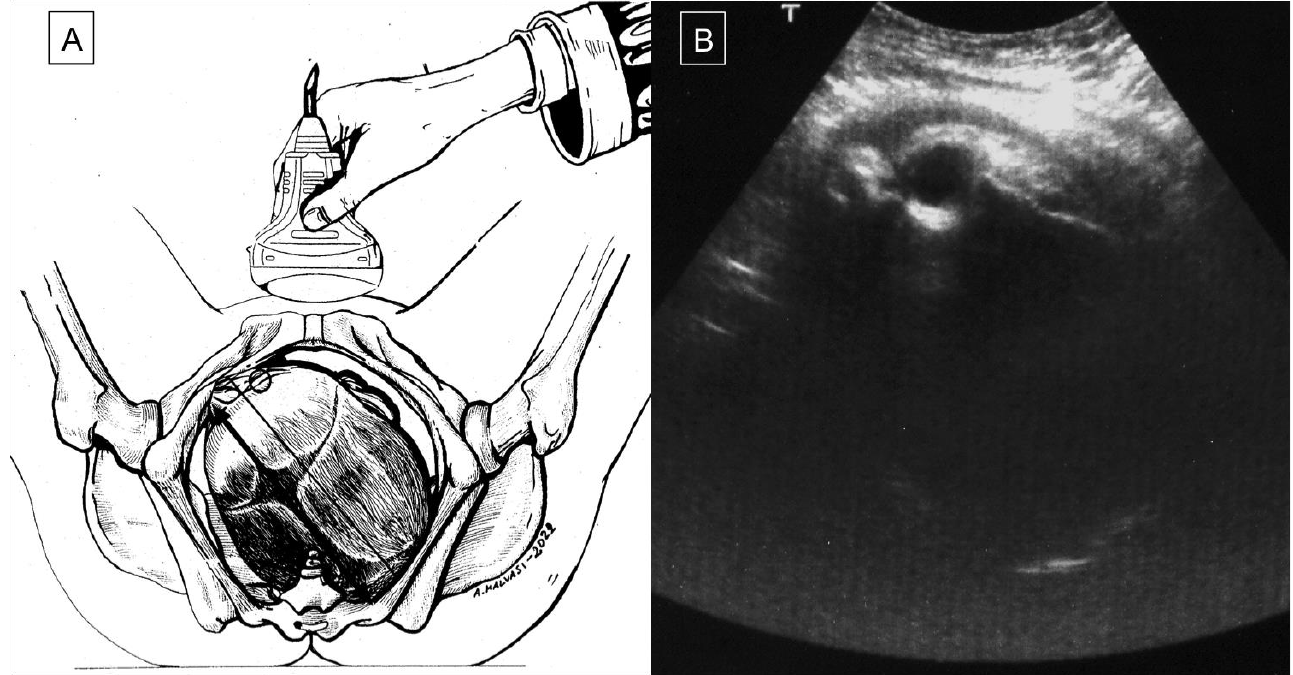
Figure 2. During a prolonged second stage of labor, the operator assesses the fetal head using a suprapubic transabdominal scan, orienting the probe transversely ( A ); the occiput position is left posterior, and the right orbit clearly visible in the upper left quadrant of the screen is the “anterior squint sign” , which enables diagnosis of an anterior asynclitism fetal head attitude ( B ).